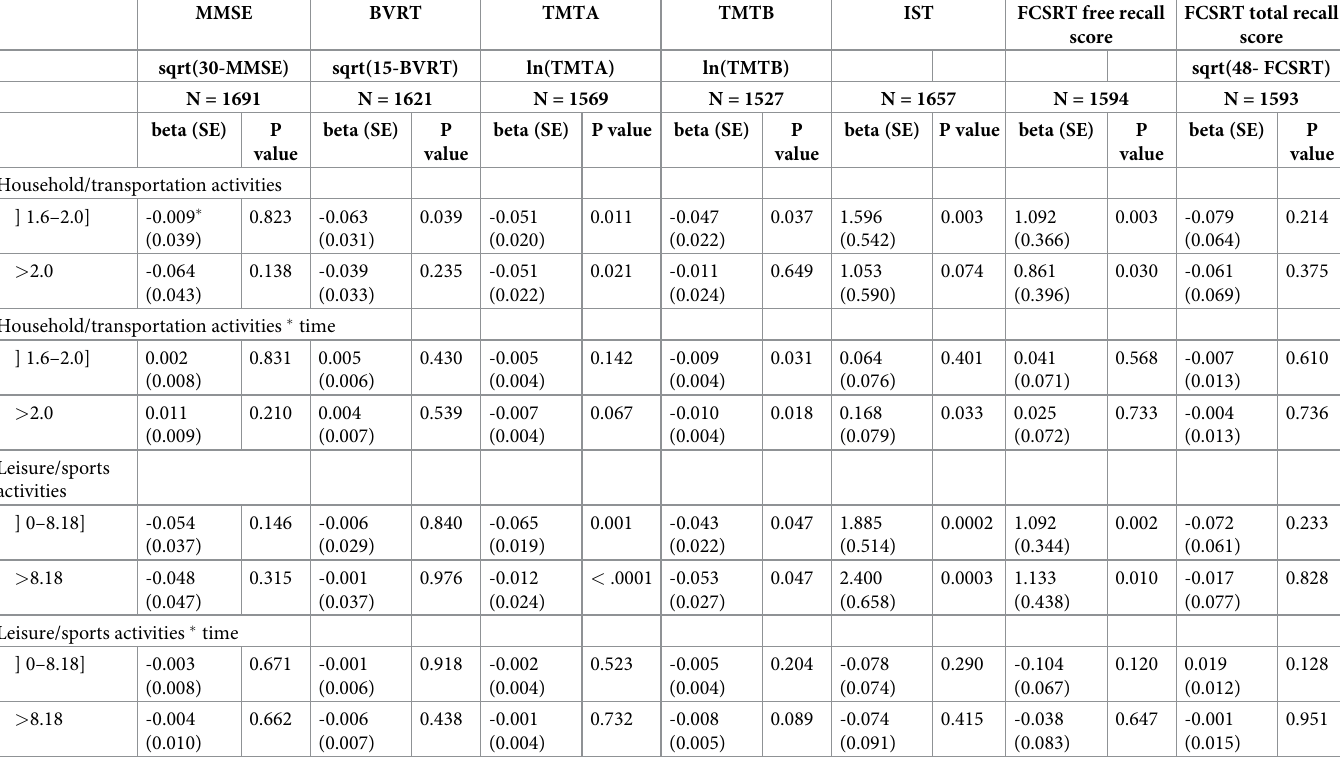
Table 2. Association of physical activity with cognitive changes (minimally adjusted model �